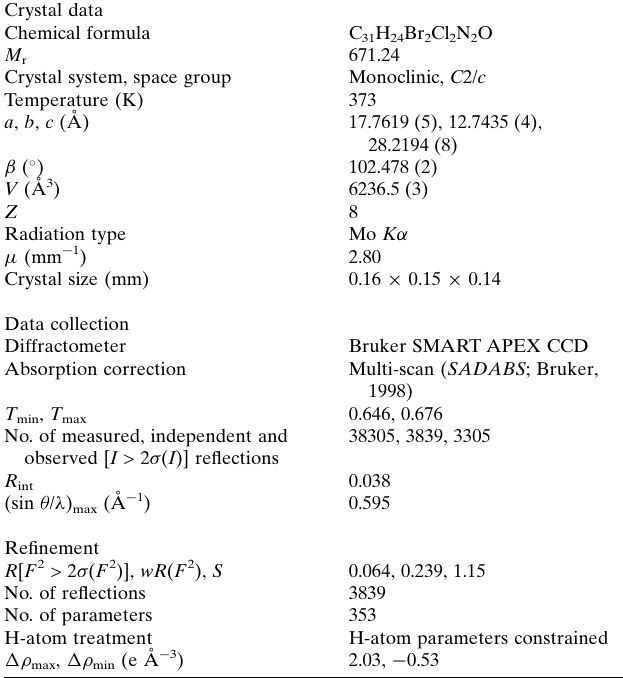
Table 1 Hydrogen-bond geometry (A˚ , (cid:3) ). Cg 2 and Cg 4 are the centroids of the C4–C9 and C20–C25 rings, respectively.